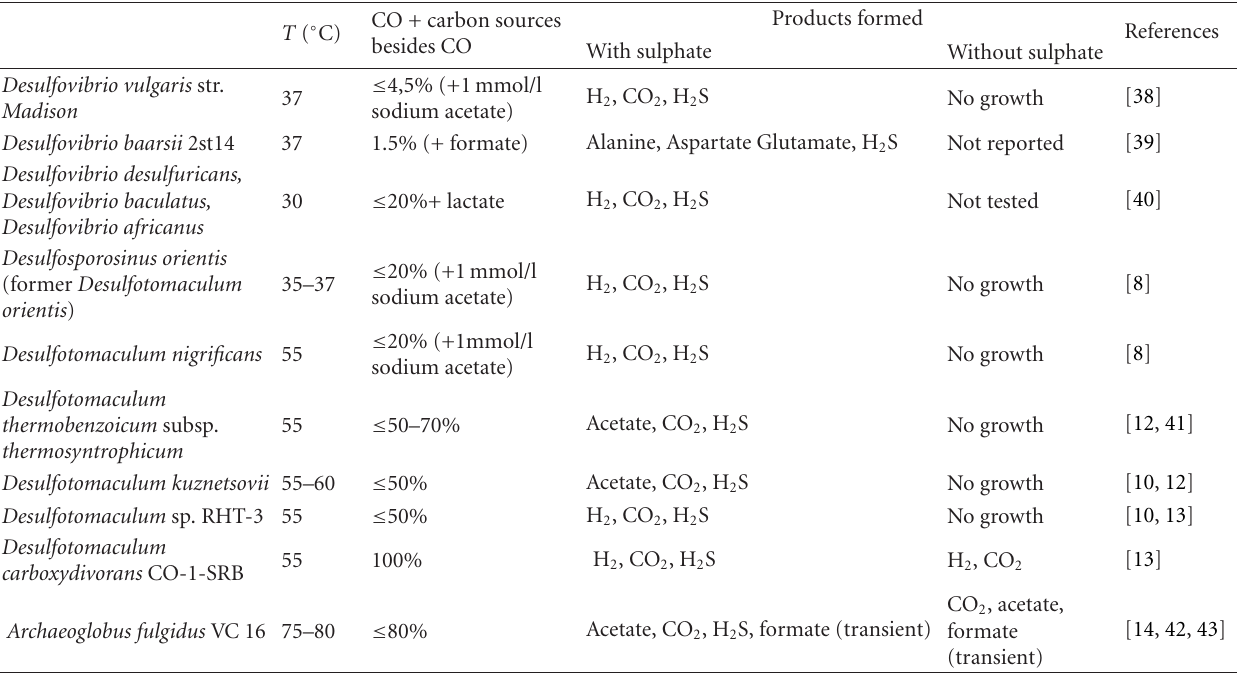
Table 1: Tolerance and use of CO by tested sulphate